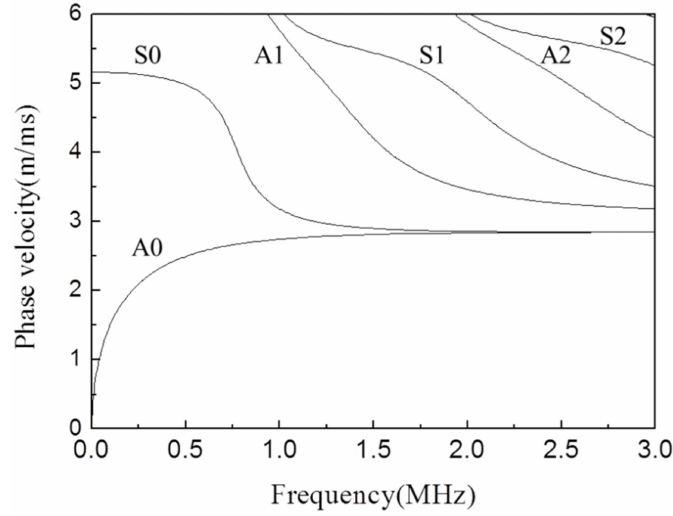
Figure 3. Calculation result of dispersion curve for 3 mm thick 304SS plate.